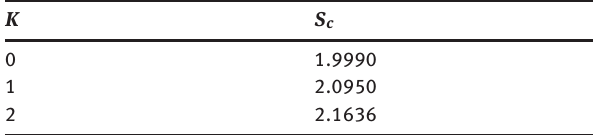
Table 3: Critical values of S c for different values of K when Nb